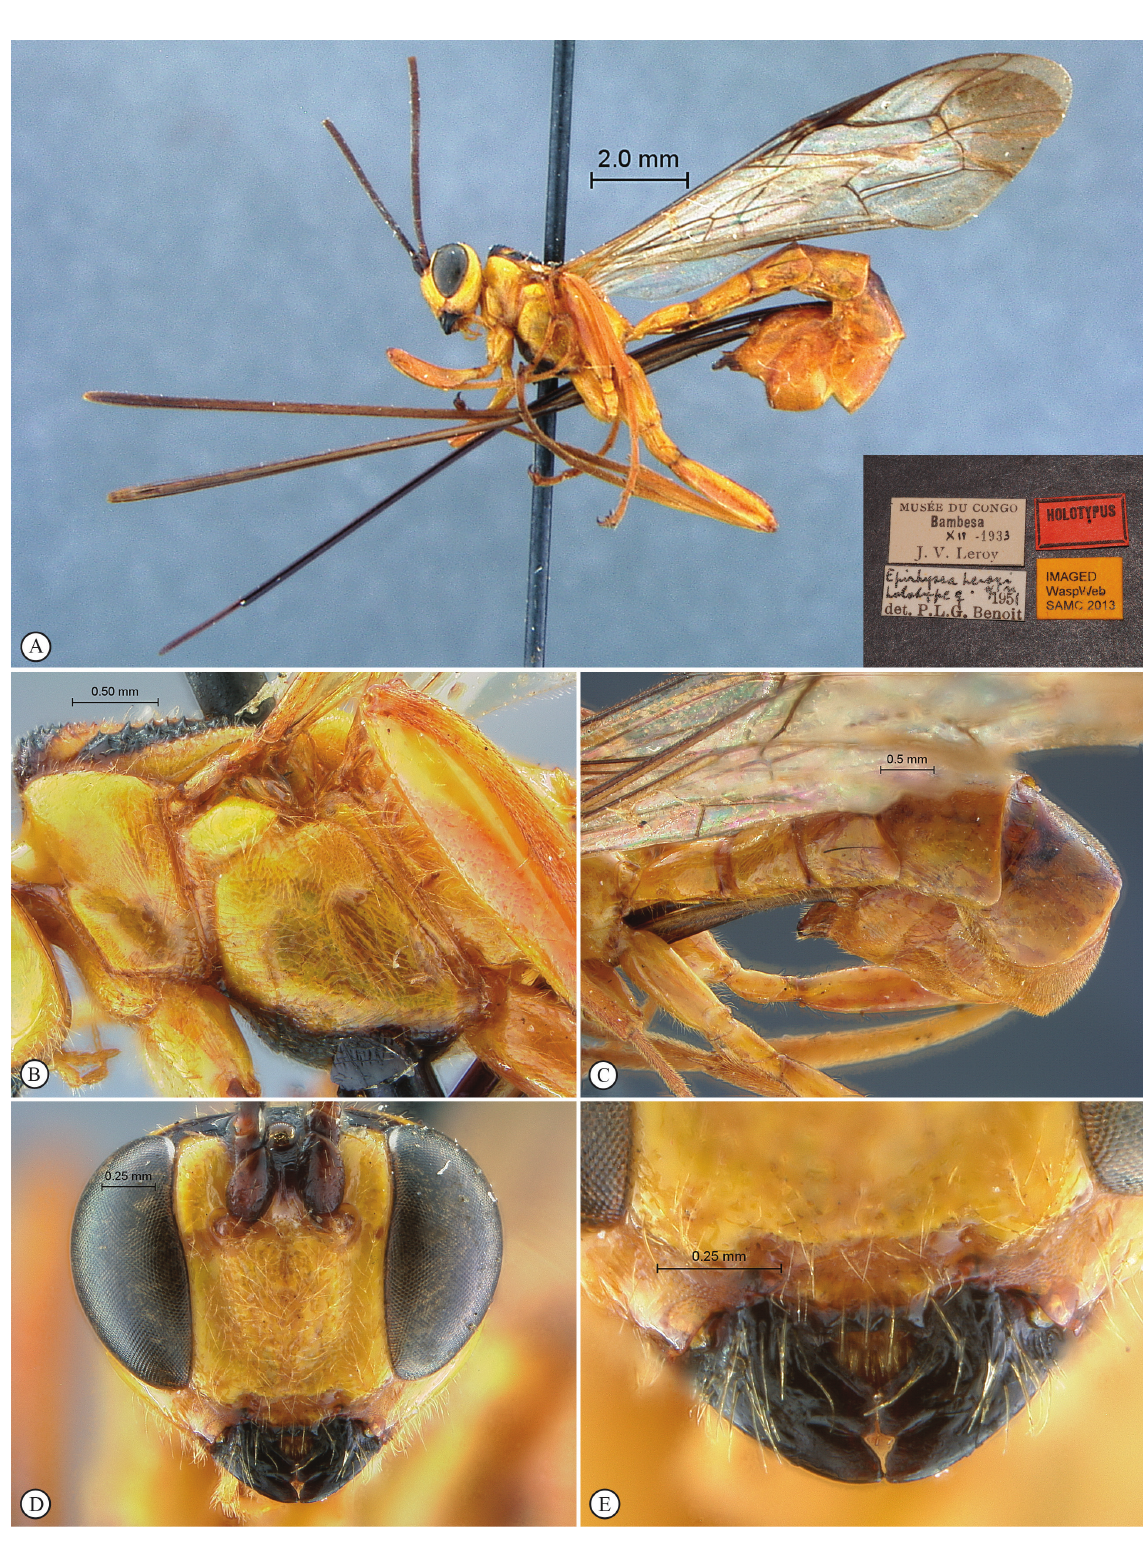
Fig. 4. Epirhyssa leroyi Benoit, 1951, holotype, ♀. A . Habitus, lateral view (inset: data labels). B . Mesosoma, lateral view. C . Metasoma, dorsal view. D . Head, anterior view. E . Mandibles, anterior